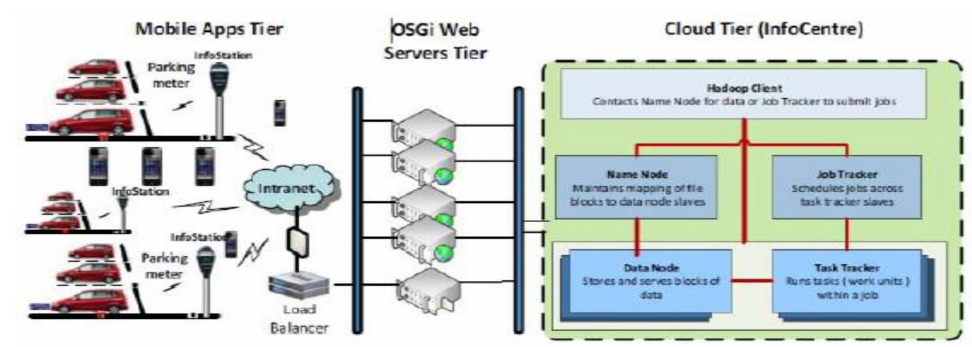
Figure 5. Smart parking transportation architecture